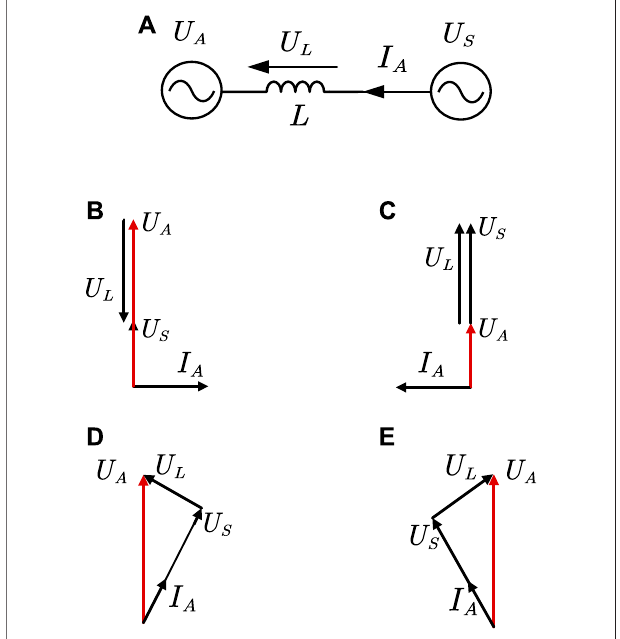
FIGURE 2 | Schematic diagram of power